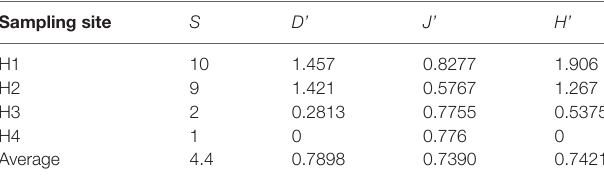
TABLE 1 | Indexes of the biodiversity analysis of the macrobenthos community in Haima cold seep.